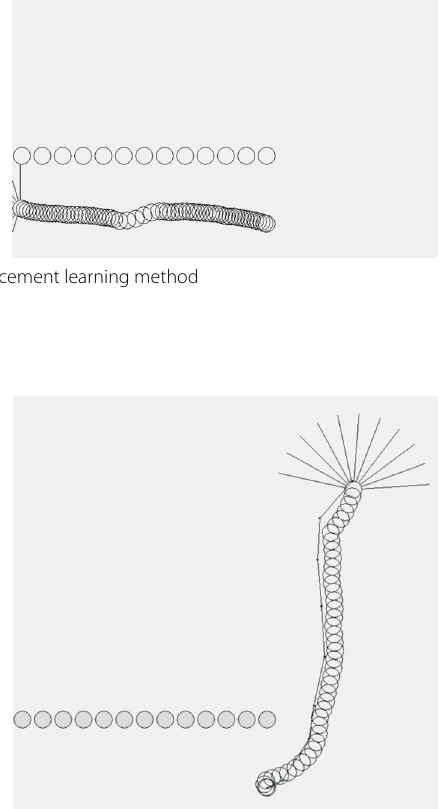
Fig. 18 Dynamic path following